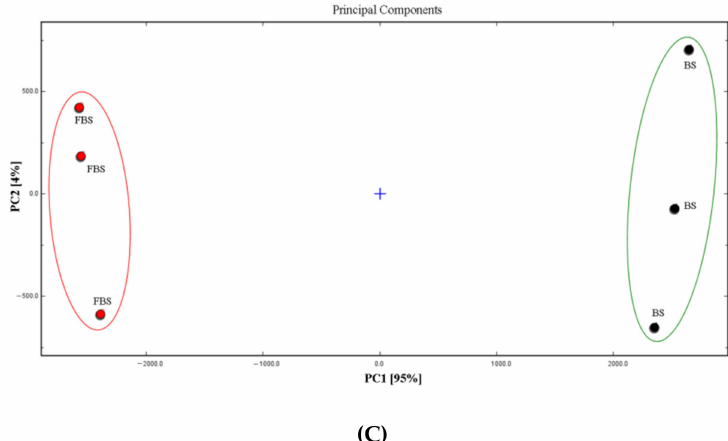
Figure 4. ( A ) Representative three-dimensional topographical plot of volatile fingerprints in non-fermented black soybeans (BS) and E. cristatum -fermented black soybeans (FBS). ( B ) Changes volatile compounds in the two-dimensional (2D)- topographic of black soybeans during solid-state fermentation with E. cristatum . ( C ) Principal component analysis (PCA) of volatile organic compounds based on the signal intensity obtained with non-fermented black soybeans (BS) and E. cristatum - fermented black soybeans